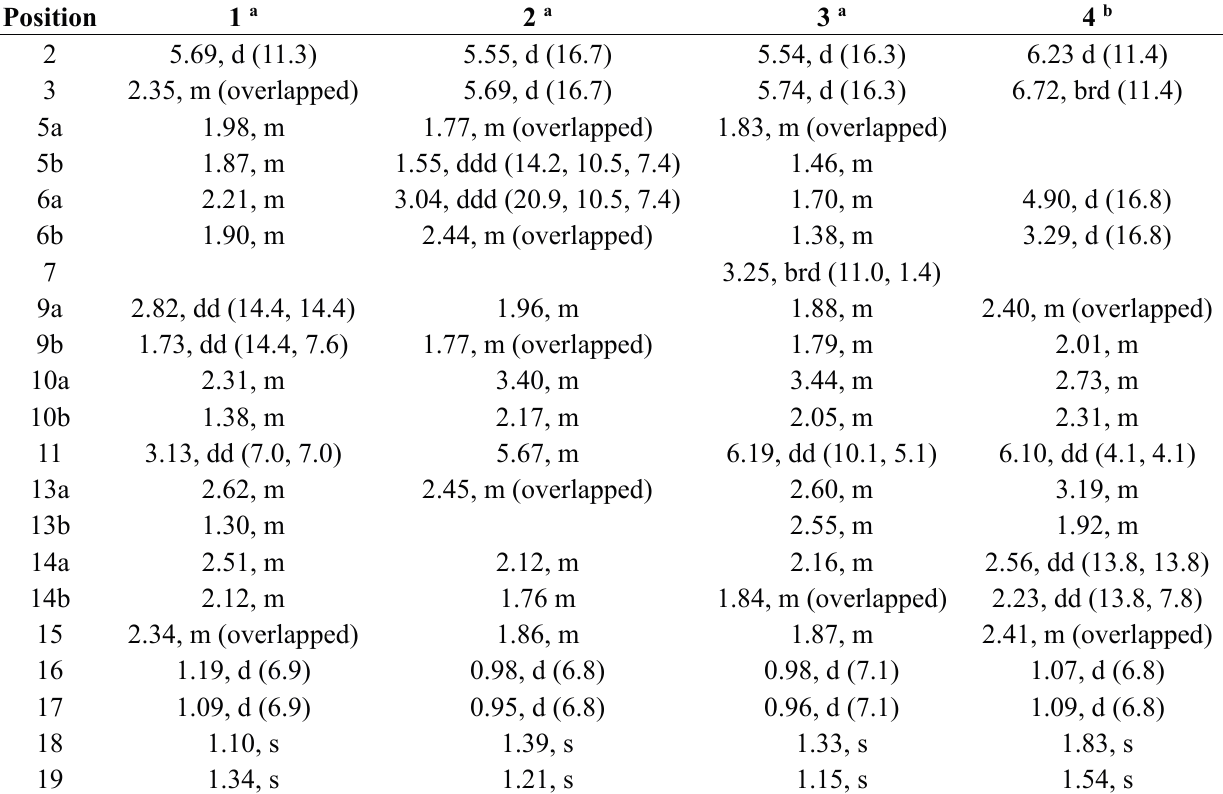
Table 1 . 1 H-NMR spectroscopic data of 1 – 4 (400 MHz, J in Hz, δ in ppm).